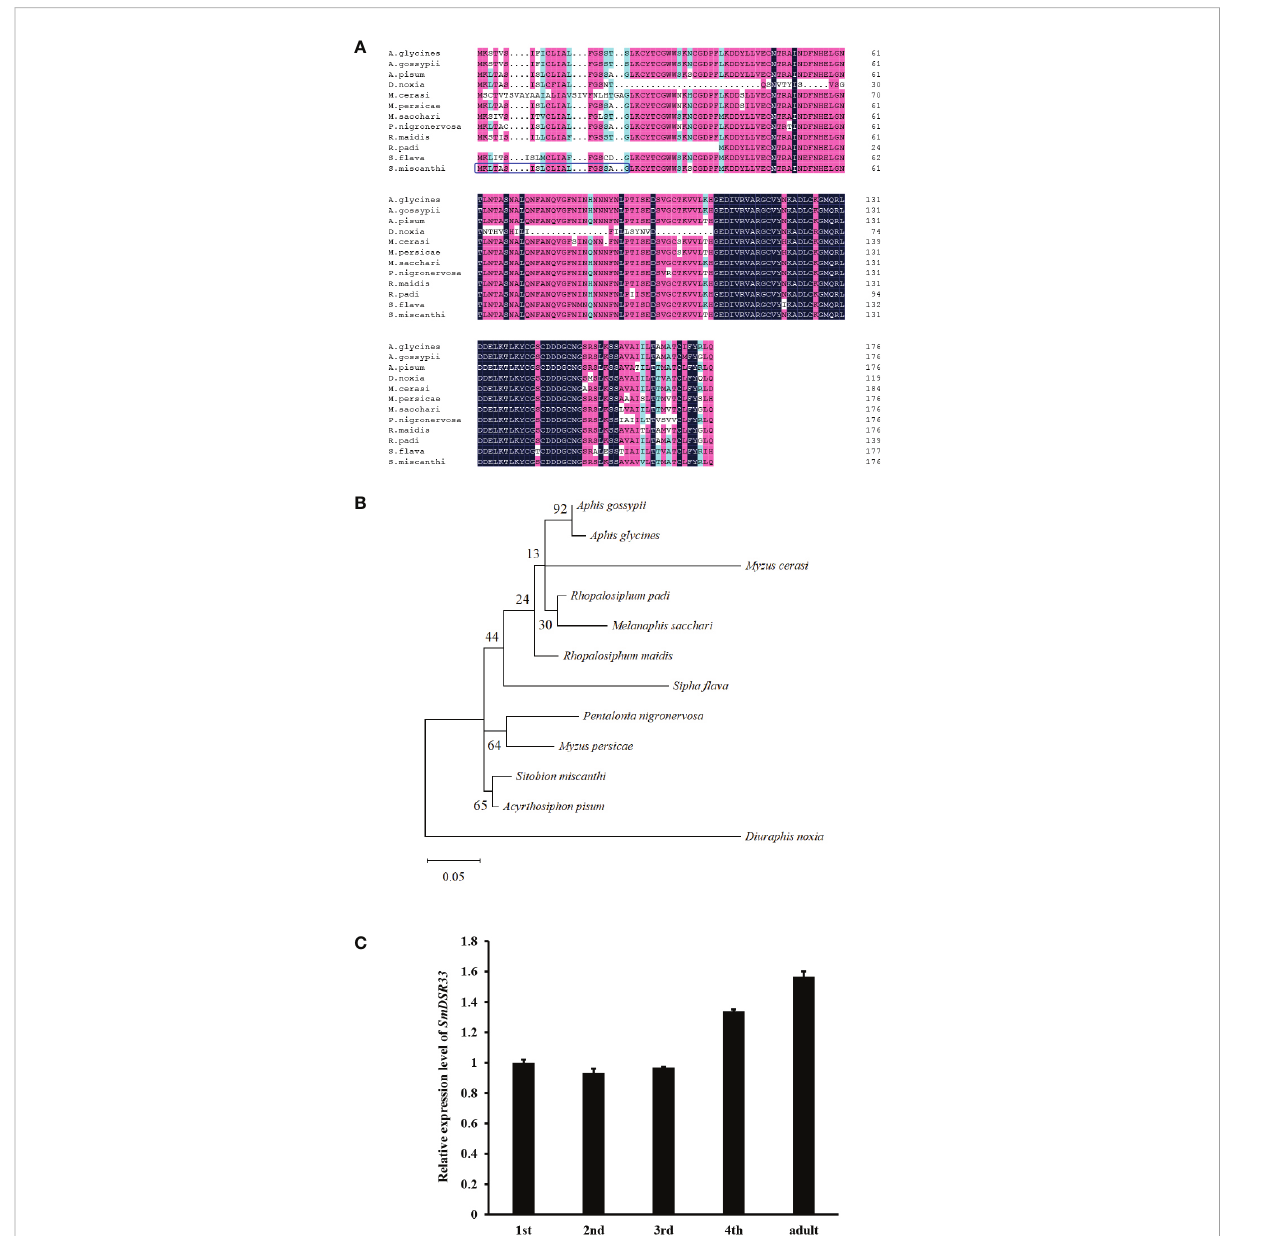
FIGURE 1 Characterization of SmDSR33. (A) Multiple sequence alignment of SmDSR33 protein and orthologs from other aphid species. The deduced amino acid sequences from eleven aphid species include Acyrthosiphon pisum (NM_001163178.1), Aphis glycines (AG000929-RA), Aphis gossypii (XM_027996540.1), Diuraphis noxia (XM_015509488.1), Melanaphis sacchari (XM_025349621.1), Myzus cerasi (Mca00769.t1), Myzus persicae (XM_022311485.1), Pentalonia nigronervosa (g3912.t1), Rhopalosiphum maidis (XM_026949227.1). Rhopalosiphum padi (Rpa07522.t1), and Sipha fl ava (XM_025560312.1). Black shades indicate identical amino acids. Pink shades indicate similar amino acid, and blue shades include the sequences with identical and similar residues. Signal peptide of SmDSR33 is highlighted with blue box. (B) Phylogenetic tree of SmDSR33 and its homologs from other aphid species constructed with the maximum likelihood method. Bootstrap supporting values (1000 replicates) are shown at the branch nodes. (C) The expression pro fi le of SmDSR33 in grain aphid at different development stages. The expression pro fi les of SmDSR33 at different developmental stages of grain aphids fed on wheat. Values and error bars represent the mean and SEM of three independent biological replicates, each with a pool of 15 individual